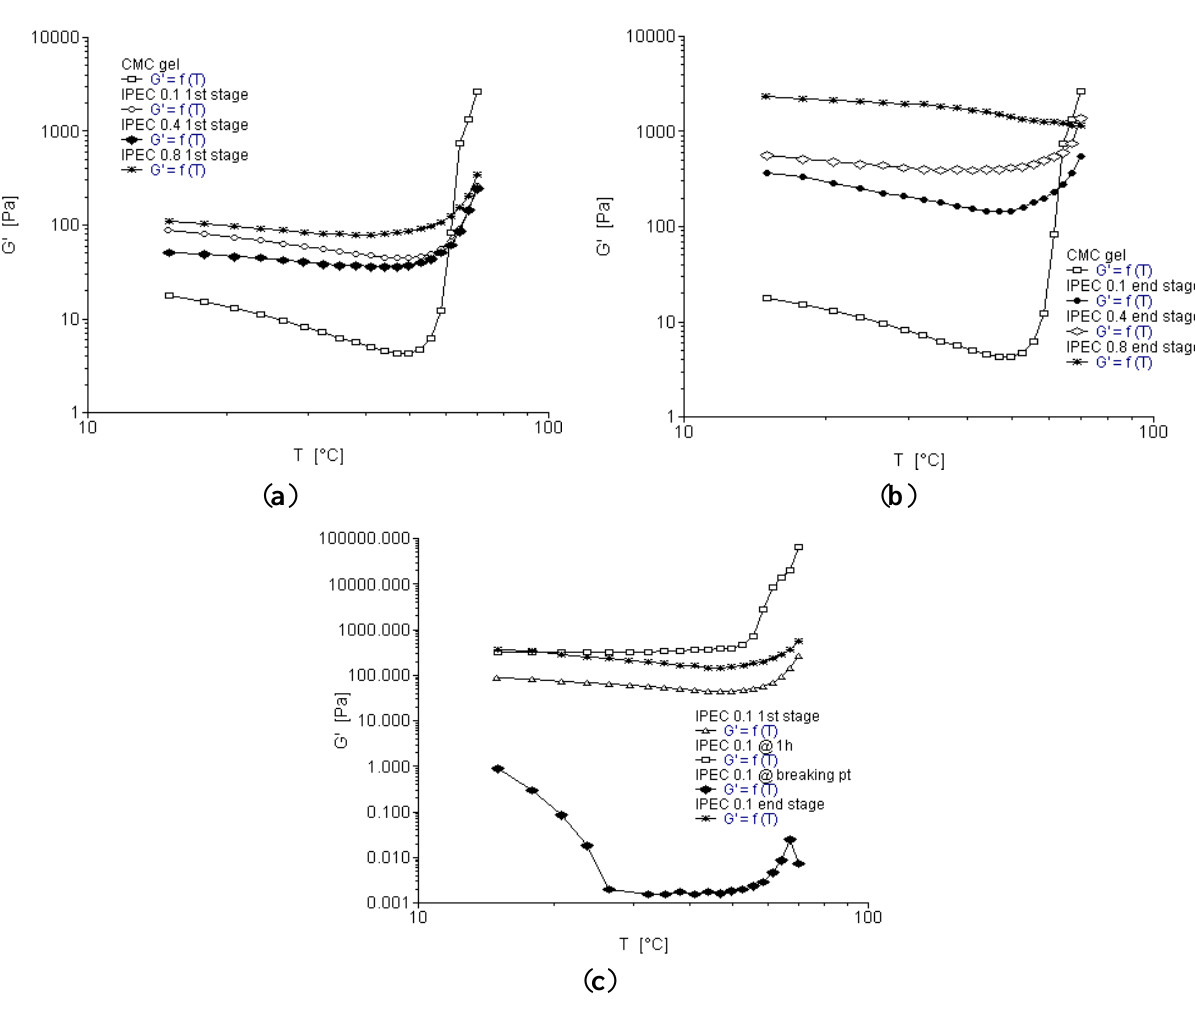
Figure 8. Elastic modulus as a function of temperature for ( a ) NaCMC and IPEC at the first stage of synthesis; ( b ) NaCMC and IPEC at the end stage of synthesis; and ( c ) IPEC 0.1 N at the four sampling points of